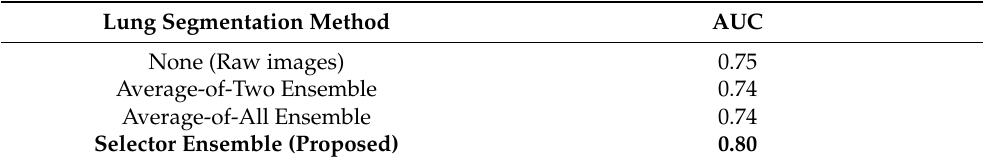
Figure 8. ROC curves generated for TB detection on CRs with different lung segmentations applied. The Raw Images result is for no lung segmentation. The other curves correspond to lung segmentation using the listed ensemble method. Table 8. TB detection results with different lung segmentation methods. Detection performance is measured with AUC values for the ROC curves for each method. The row corresponding to the highest AUC value is marked in